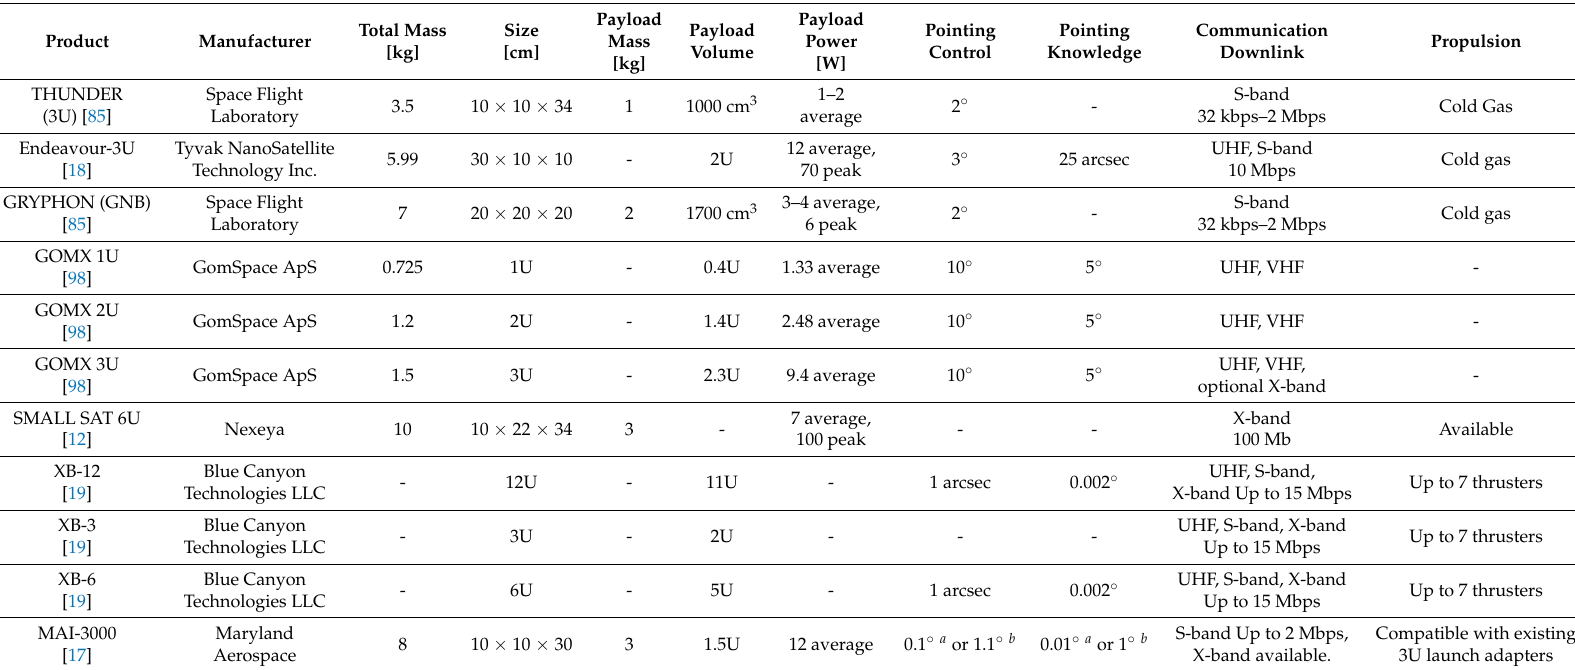
Table A1. Survey of available nano-satellite platforms for Earth